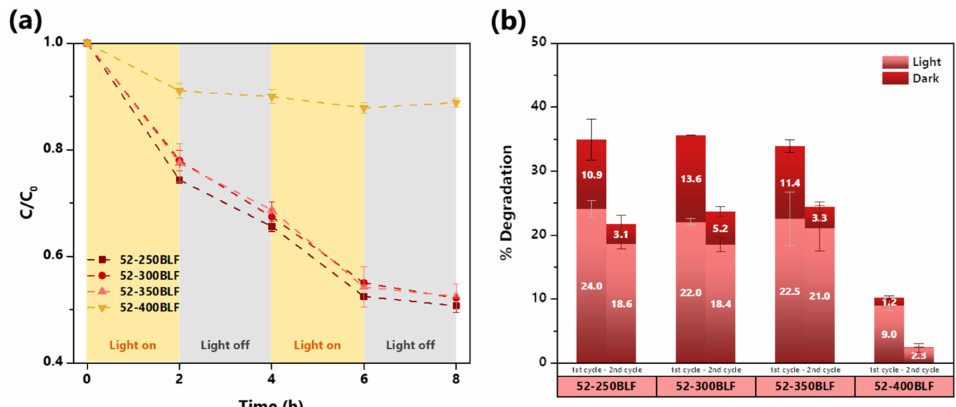
Figure 8. Photocatalytic degradation of BLF catalysts at four different calcination temperatures to obtain NiO by: ( a ) relative concentration over time and ( b ) degradation in light and dark conditions for each